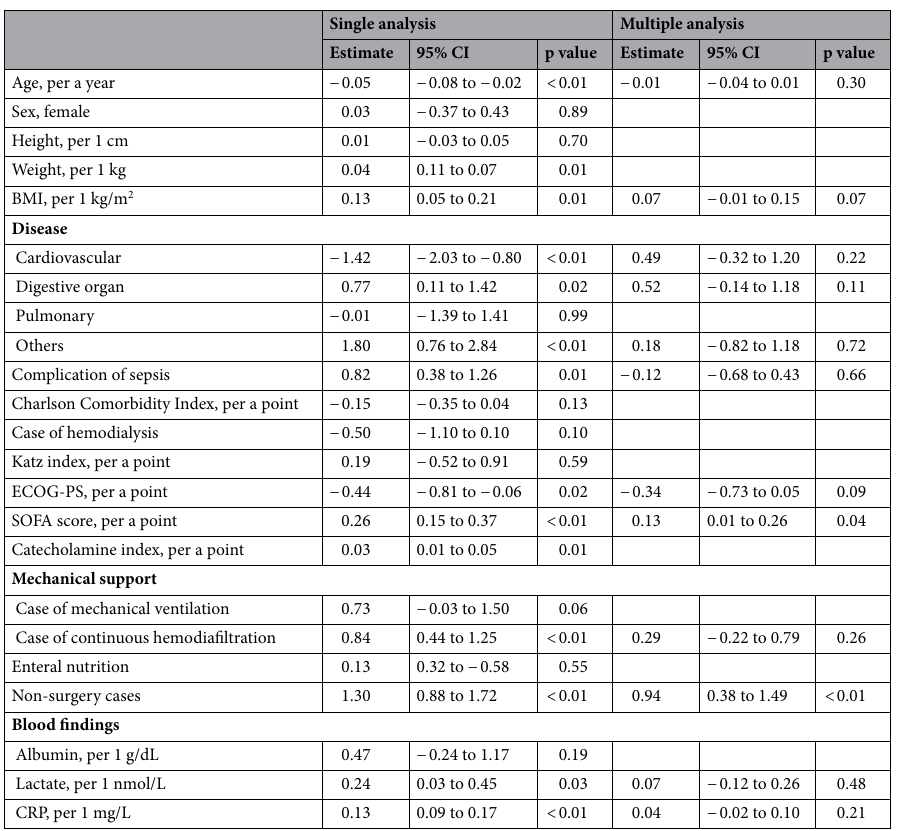
Table 2. Association to sedation period by single and multiple liner regression. BMI body mass index, ECOG-PS The Eastern Cooperative Oncology Group Performance Status, SOFA sequential organ failure assessment, CRP C-reaction